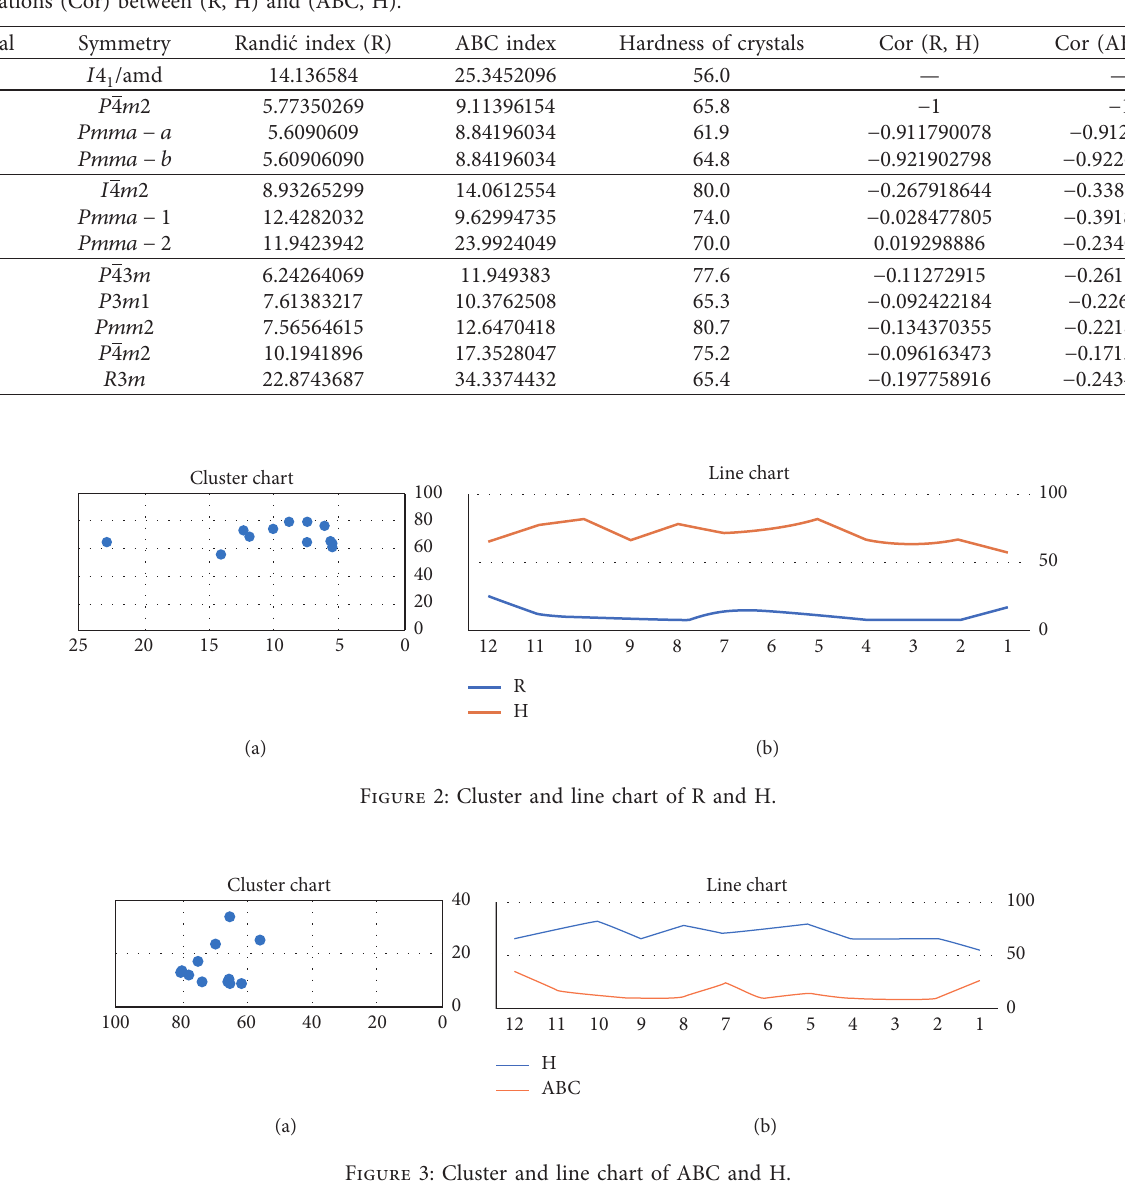
Table 2: Hardness (H) of crystals BC BC